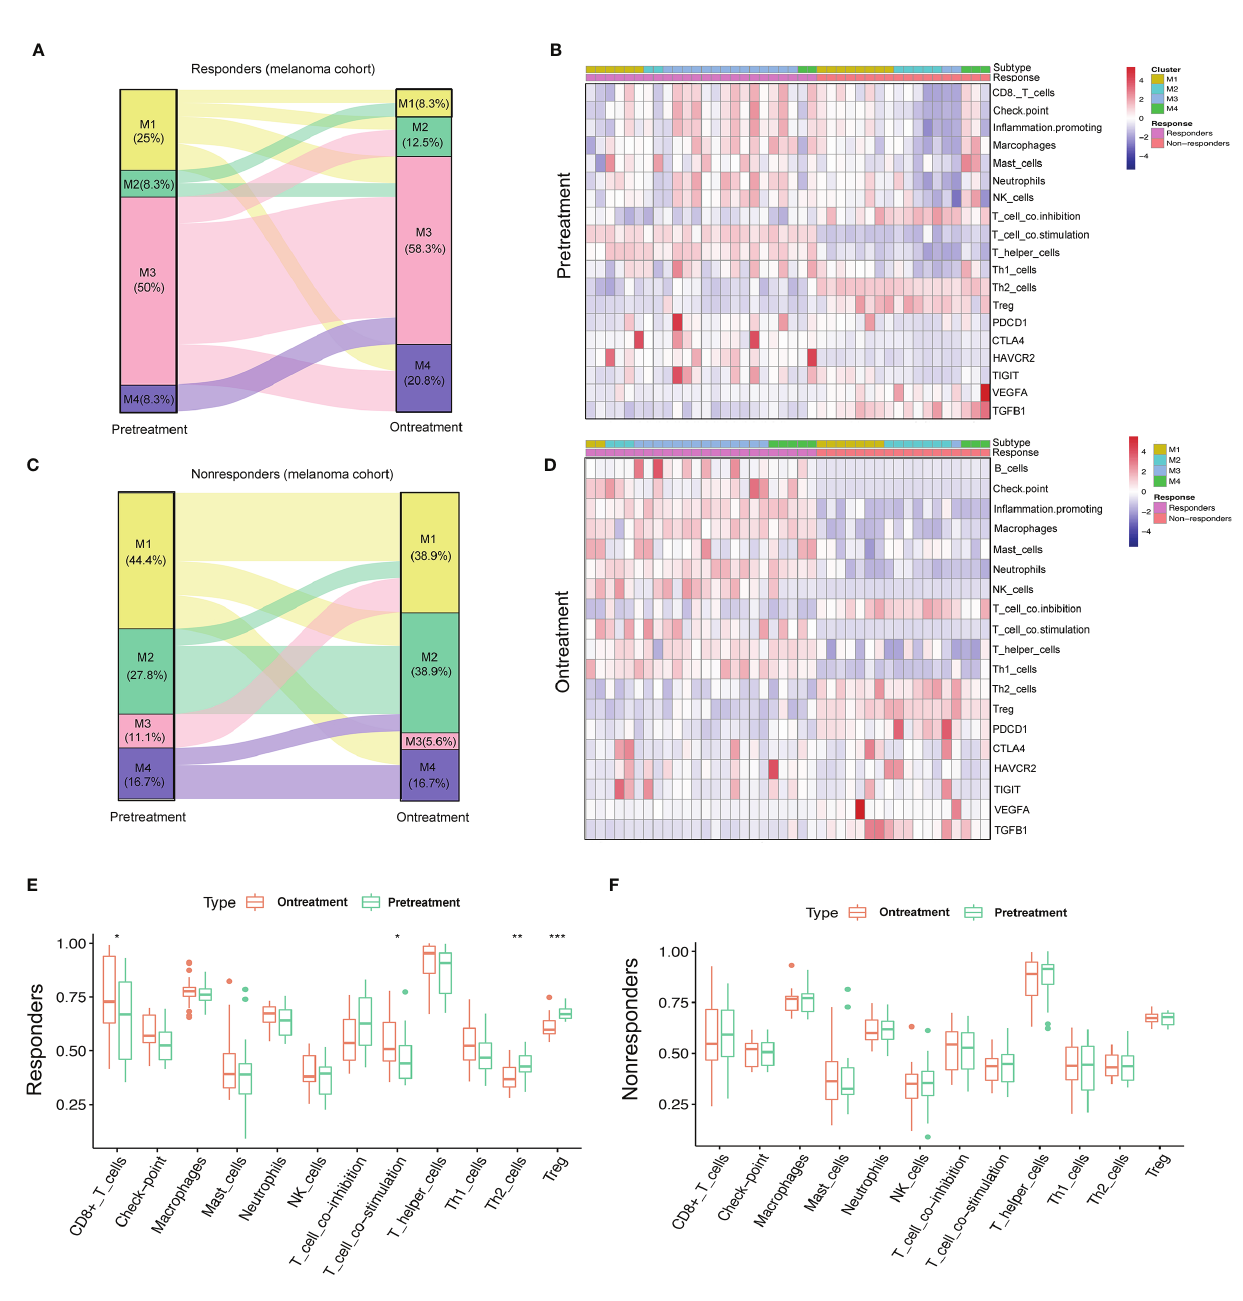
FIGURE 6 | Dynamic change pattern of immunometabolism subtypes during the immunotherapy. (A, B) Sankey diagram shows the fl ow change of immunometabolism subtypes of the responders (n=24) and non-responders (n=18) to anti-PD-1 therapy pretreatment and on-treatment. (C, D) Heatmaps show the immune components and immune relevant molecules of patients pretreatment and on-treatment. (E, F) Boxplots compare the differences of immune components pretreatment and on-treatment. p-value is given by Wilcoxon rank-sum test. *p < 0.05, **p < 0.01, ***p <